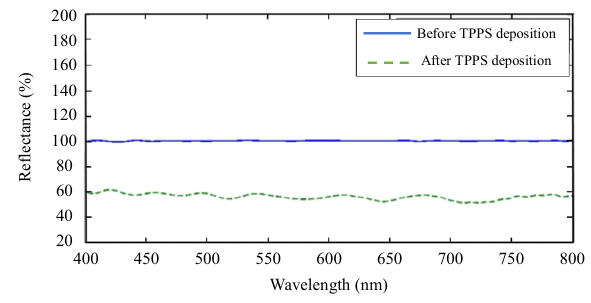
Fig. 3 Reflectance spectra of TPPS deposited on the fiber end.